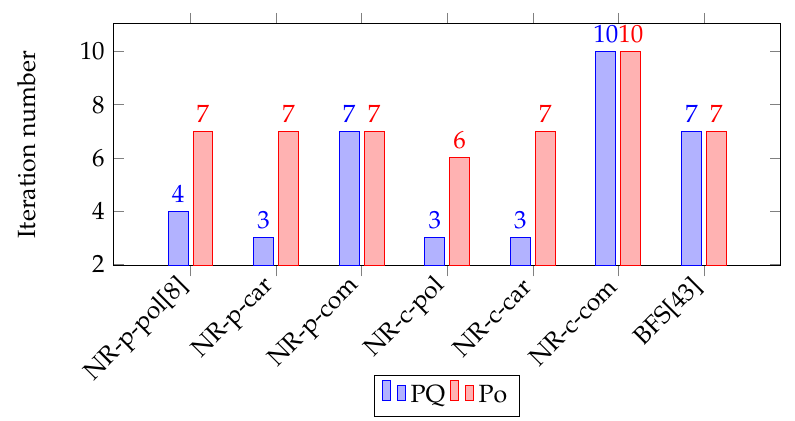
Figure 7. Convergence result for different load models (constant power (PQ) and polynomial (Po)) in